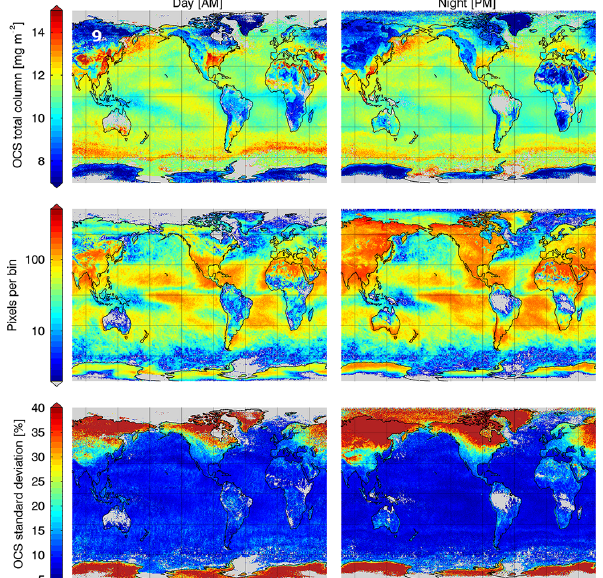
Figure 10. January–February 2014: linear estimates of total column OCS median values are shown in the top row for sun-illuminated morning (left column) and night-time evening (right column). The results are binned by latitude–longitude widths of 0 . 5 ◦ × 0 . 5 ◦ . The middle row shows the number of pixels per spatial bin that passed the quality control checks. The bottom row shows the sample stan- dard deviation of OCS per bin for the 2-month interval. Spatial bins with missing data are coloured grey.